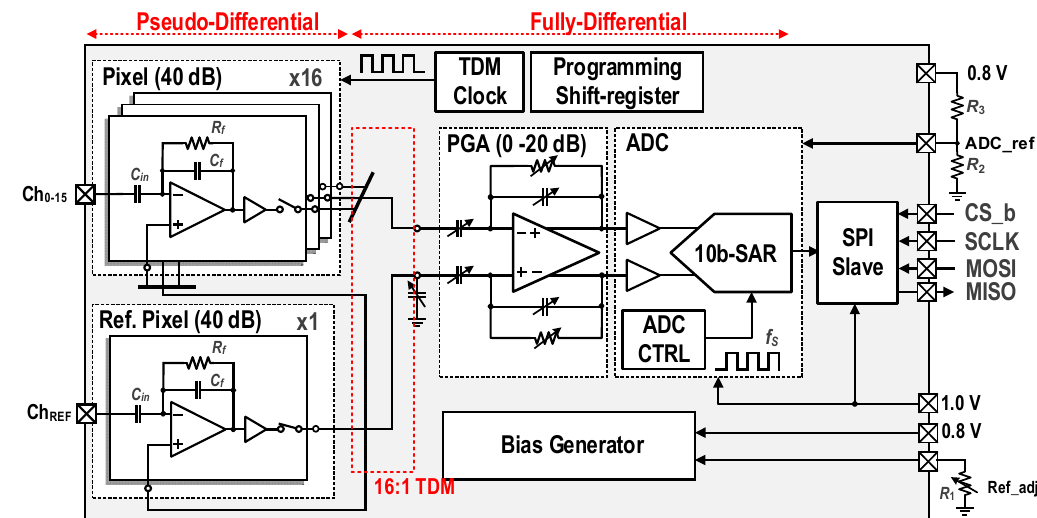
Figure 2. Conceptual circuit block diagram of the presented 16-channel AC-coupled neural recording frontend.